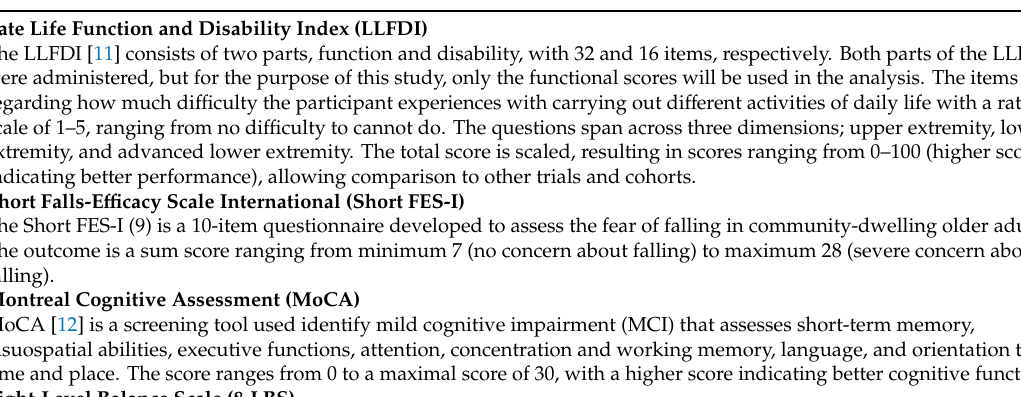
Table A1. Complete list of standard clinical tests with